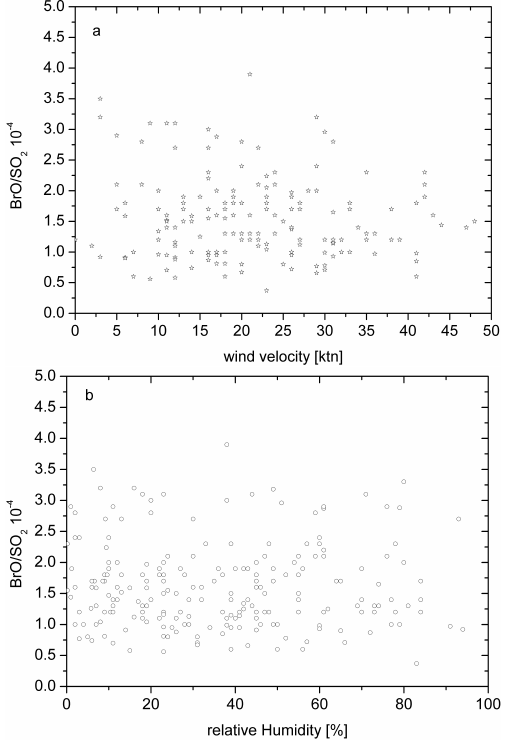
Fig. 5. (a) BrO/SO 2 ratio taken at a distance of about 6km from the summit of Etna shown as a function of wind velocity (data taken from http://weather.uwyo.edu/upperair/sounding.html) for the day of measurements and altitude of about 3000m, no dependency vis- ible. (b) BrO/SO 2 ratio taken at a distance of about 6km from the summit of Etna shown as a function of relative humidity (data taken from http://weather.uwyo.edu/upperair/sounding.html) for the day of measurements and altitude of about 3000m, no dependency vis-